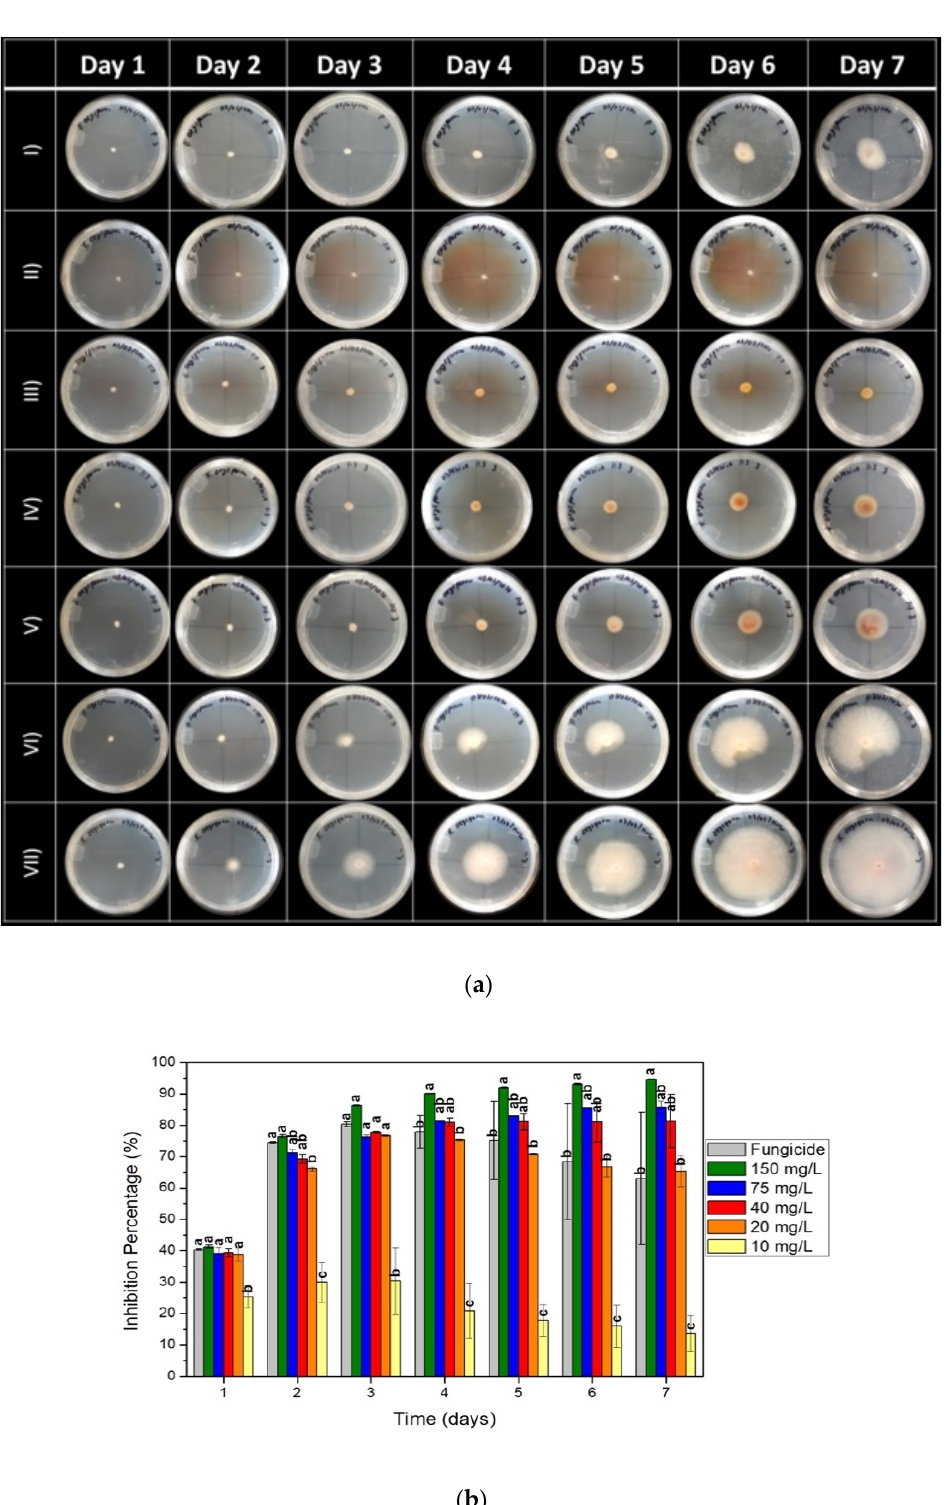
Figure 2. Fol mycelial growth inhibition test treated with AgNPs, synthesized by the green route: ( a ) plates treated with: ( I ) the Fungicide (Captan 2500 mg/L), ( II ) 150 mg/L, ( III ) 75 mg/L, ( IV ) 40 mg/L, ( V ) 20 mg/L, ( VI ) 10 mg/L AgNPs, and ( VII ) sterile distilled water (control); ( b ) per- centage of inhibition of mycelial growth over 7 days. Significance testing was performed using analysis of variance ANOVA and Tukey’s test, p < 0.05. Statistically significant differences are indicated by letters